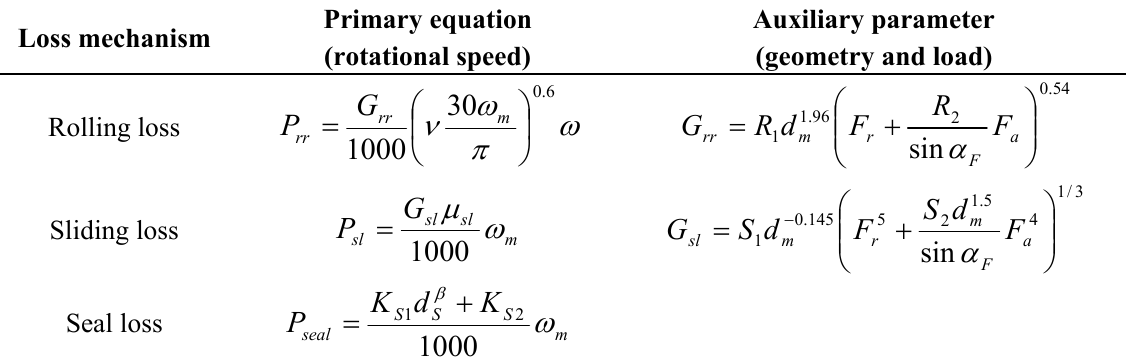
Table 3. Analytical description of power-loss in sealed ball